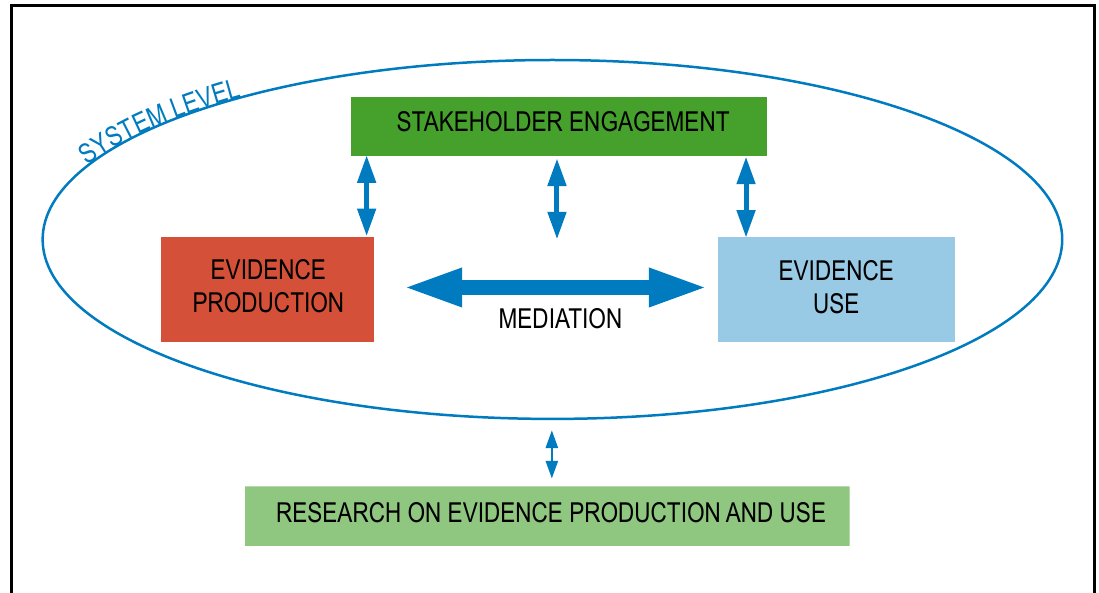
RESEARCH ON EVIDENCE PRODUCTION AND